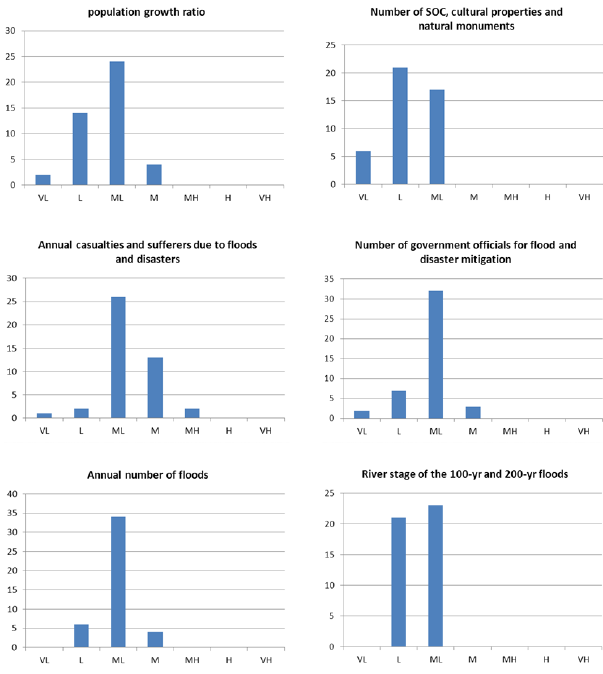
Figure 6. Standardized results of collected weights for